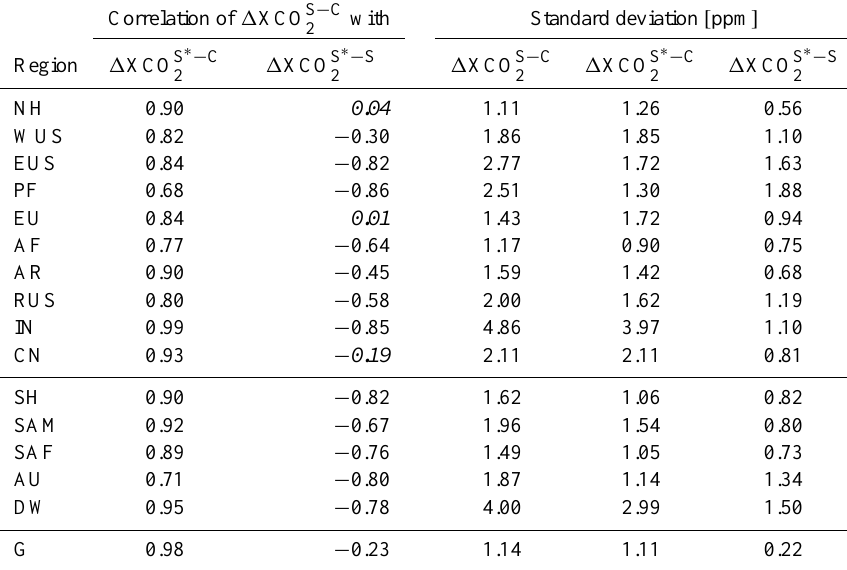
Table 3. Results of the comparison of the scan-angle-bias corrected (S ∗ ) and uncorrected (S) SCIAMACHY WFMDv2.1 XCO 2 with Car- bonTracker (C). Listed are correlation coefficients ( r , left) and standard deviations (right). Italic correlation coefficients are non-significant (see Sect. 6.1). The results shown are based on monthly data.